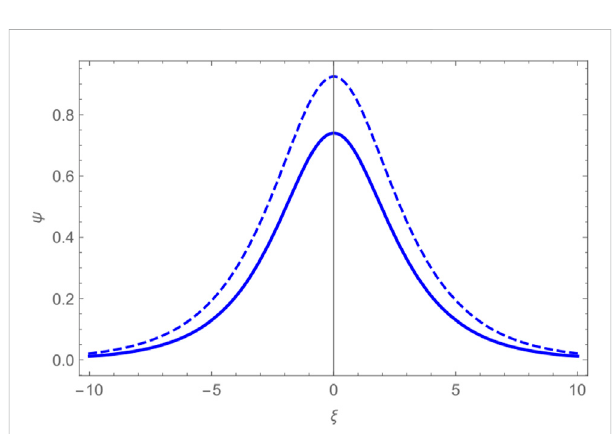
FIGURE 7 Comparison of two periodic waves: the dashed line represents α =0 and thick line represents α =0.1 drawn for A > 0 and 2 m 2 − 1 >